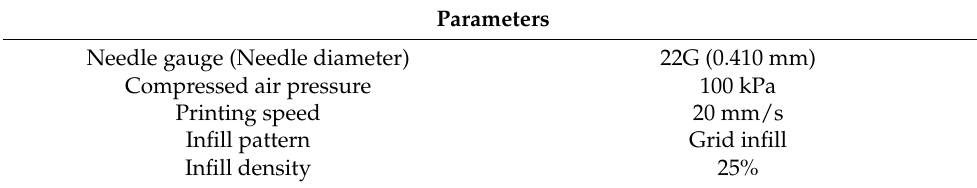
Table 2. Optimised printing parameters used in this